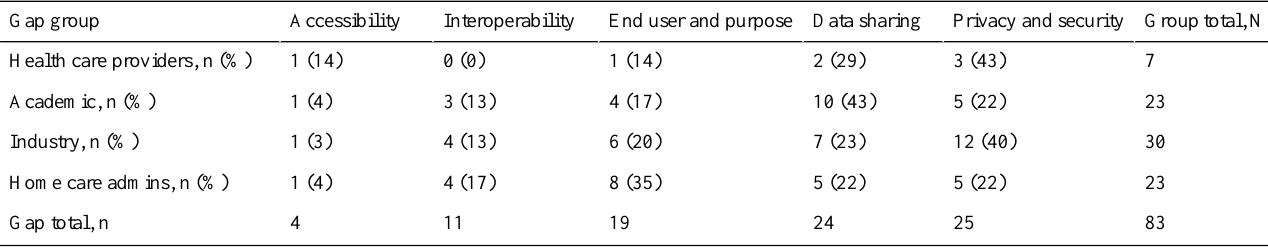
Table 2. Number of times a gap was mentioned by a group of stakeholders—interview